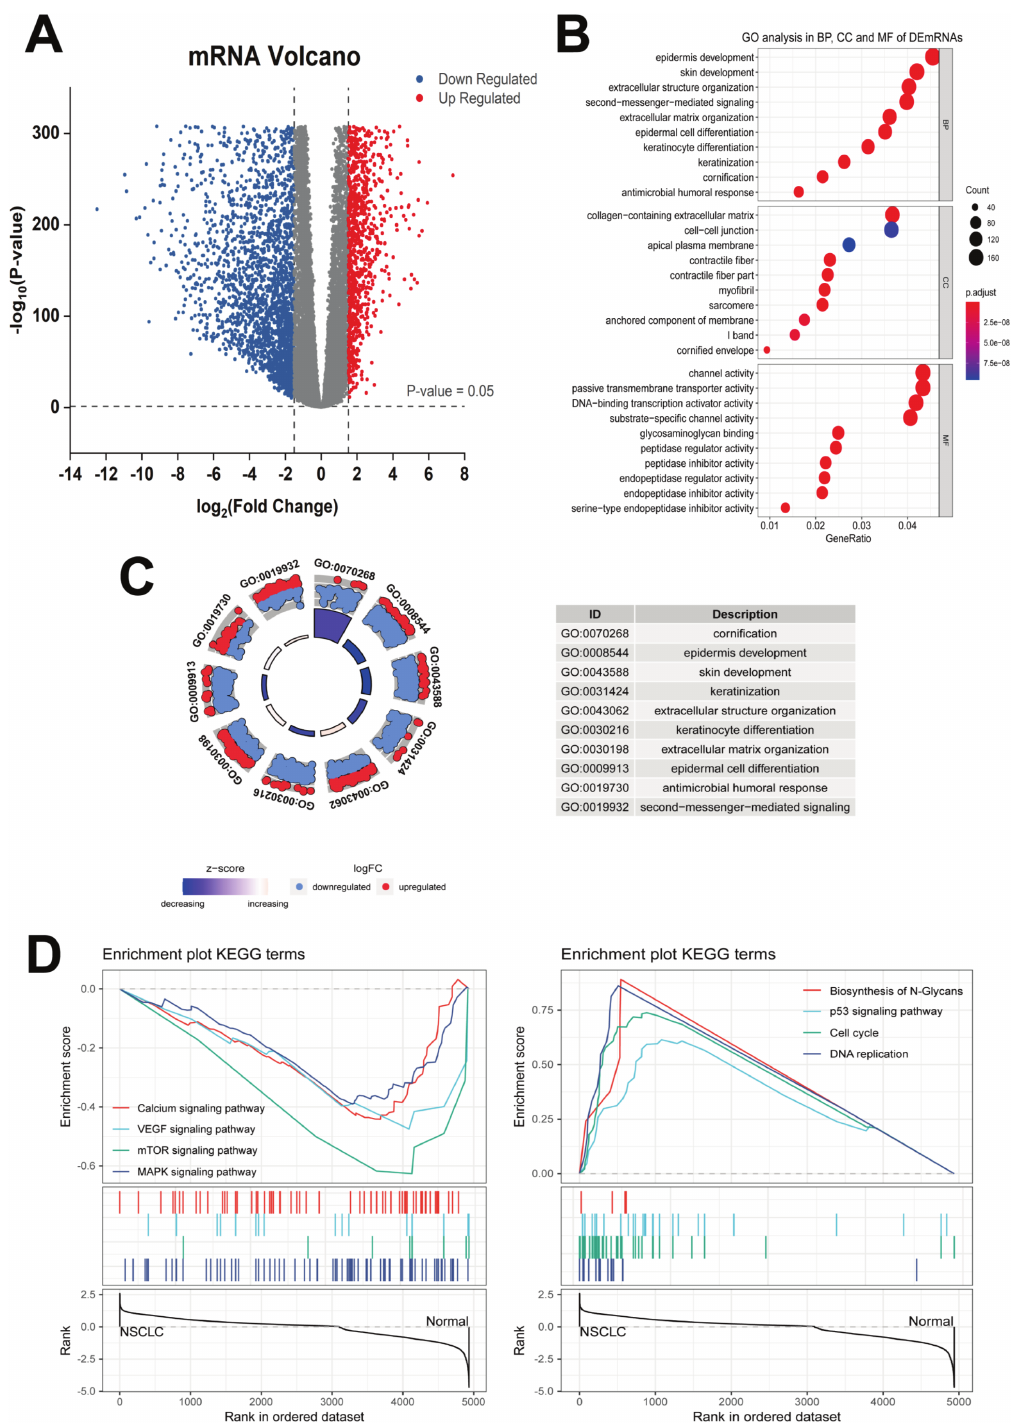
Fig 2. Analysis of DEmRNAs from TCGA and GTEx. ( A ) Volcano map of important DEmRNAs including 1838 up- regulated and 3097 down-regulated mRNAs. ( B ) GO analysis showing the involvement of BP, CC, and MF in DEmRNAs. ( C ) Distribution of DEmRNAs in BP. Red circles display up-regulated genes, and blue ones show down-regulated genes in the scatter plot of outer circle. ( D ) KEGG-GSEA was applied to the signaling pathway enrichment of DEmRNAs. TCGA, the Cancer Genome Atlas database; GTEx, the Genotype–Tissue Expression database; DEmRNAs, differentially expressed mRNAs; BP, biological process; CC, cellular component; MF, molecular function; GO, Gene Ontology.